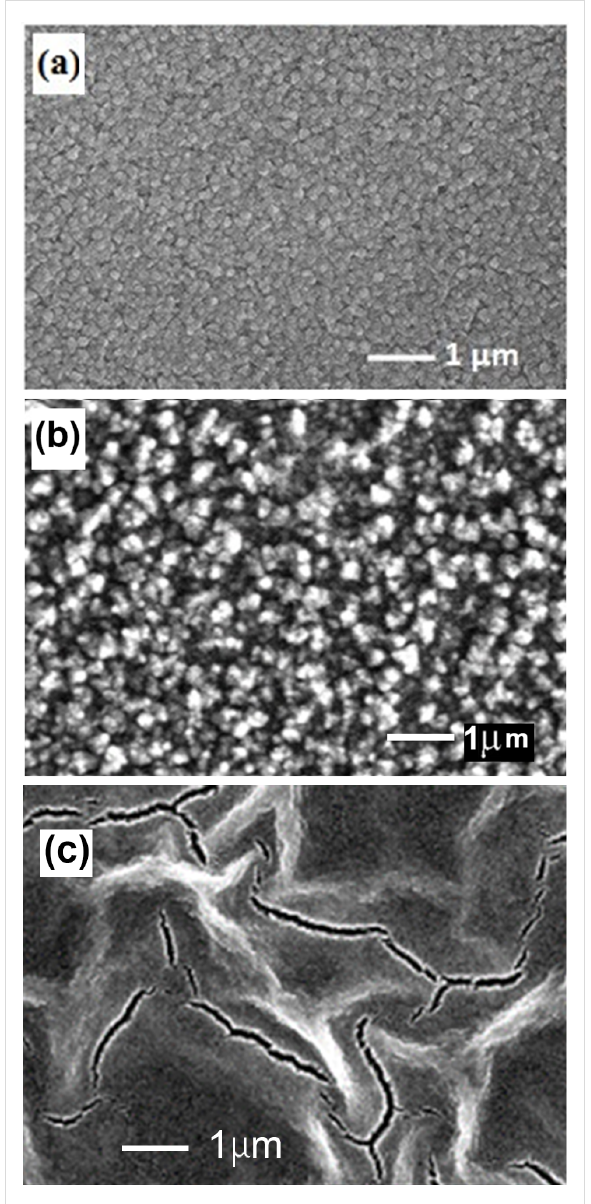
Figure 2: a) SEM image of a ZnMgO film prepared by aerosol spray pyrolysis. b) SEM image of a ZnMgO film prepared by spin coating